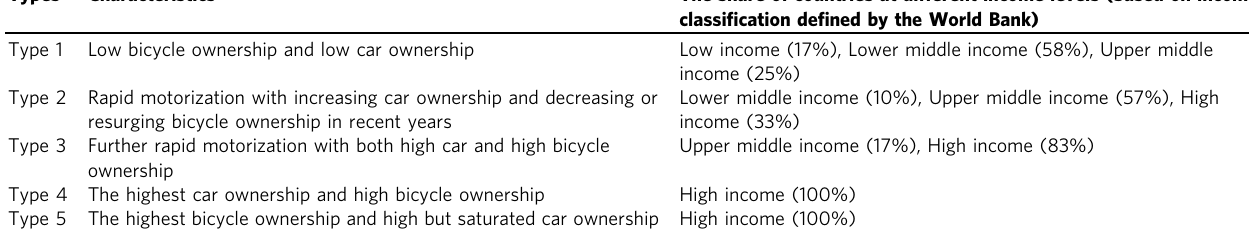
Fig. 2 Historical per-capita bicycle ownership versus per-capita car ownership from 1962 to 2015. The fi gure is divided into four quadrants with color by median values of the two in 2015 (the dashed lines in the fi gure). The fi rst (blue), second (pink), third (yellow), and fourth (green) quandrants thus indicate combinations of high bicycle ownership & high car ownership, low bicycle ownership & high car ownership, low bicycle ownership & low car ownership, and high bicyle ownership & low car ownership. The black, blue, orange, red, and green dots, letters, or lines in both inner and outer fi gures indicate Type 1, Type 2, Type 3, Type 4, and Type 5 countries respectively, which are further detailed in Table 1, Supplementary Table 8, and Supplementary Fig. 12. The country codes are based on ISO 3166-1 alpha-3 code. The indicative grey belts in both outer and inner fi gures summarize the evolutionary pattern with fi ve varying types among different Table 1 The fi ve varying types in historical development of per capita car and bicycle ownership. Types